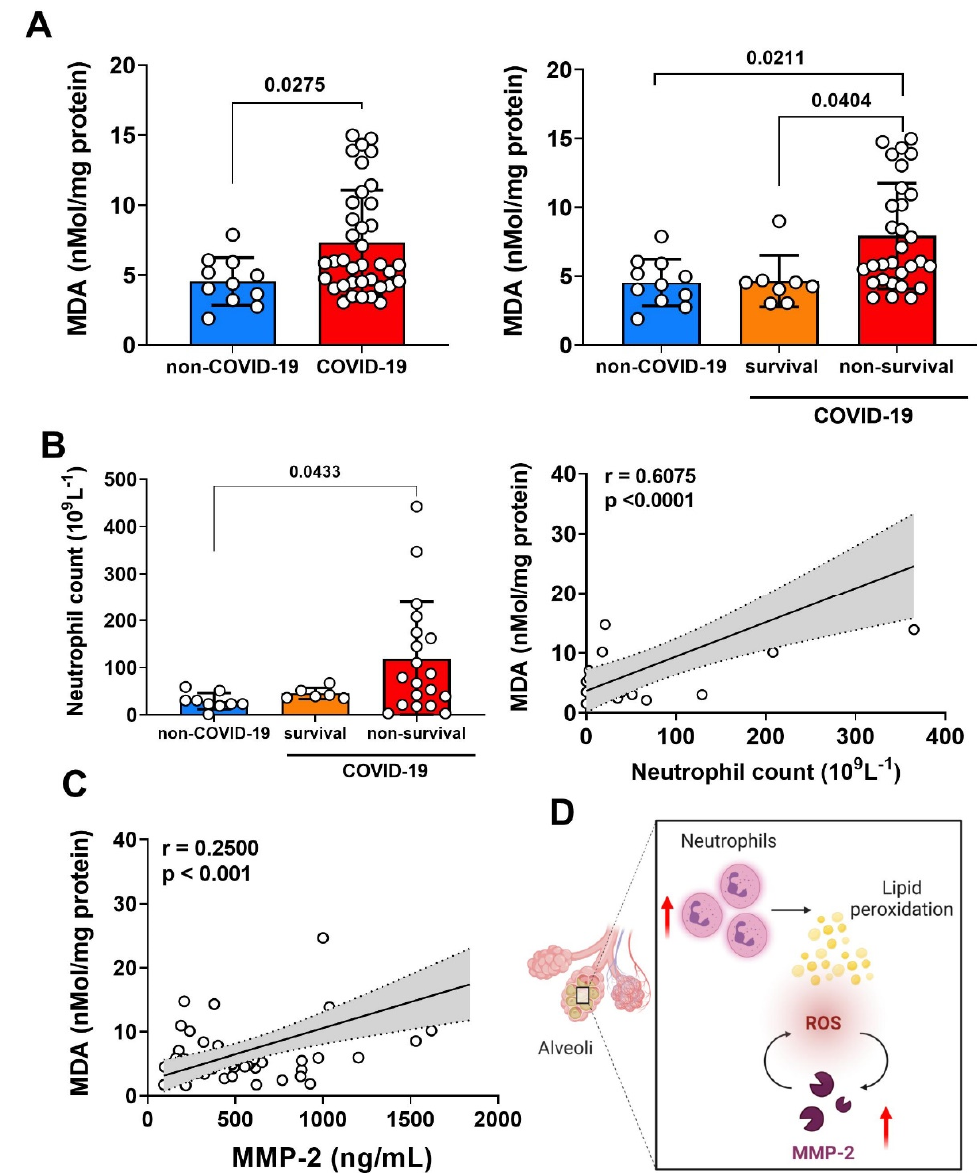
Figure 3. Oxidative stress and neutrophil infiltration into the lung of patients with severe COVID-19. ( A ) Representative lipid peroxidation levels by concentrations of thiobarbituric acid- reactive species expressed in terms of MDA in TAF samples from non-COVID-19 ( n = 13) and COVID-19 patients (survival n = 6, non-survival n = 33). ( B ) Absolute neutrophil counts in TAF samples from non-COVID-19 and COVID-19 patients (survival, non-survival), and correlation between the quantification of MDA and the number of neutrophils in total TAF samples from non-COVID-19 and COVID-19 patients at hospital admission. ( C ) Correlation between MDA quantification and MMP-2 levels in total TAF samples from non-COVID-19 and COVID-19 patients at hospital admission. Spearman correlation analysis, r and p value indicated in each panel. Statistical analyzes were performed using the Kruskal–Wallis multiple comparison test, followed by the Dunns post-test to compare pairs. Data are expressed as median with 95% confidence intervals. Statistical differences between groups are considered by p < 0.05 and represented direct in the graphic figure. ( D ) Schematic representation of the lung neutrophil infiltration and ROS pro- duction trigger a positive looping of MMP-2 and ROS production in lung from severe COVID-19. (Created with BioRender.com, Agreement number: CG23RHR5O1).